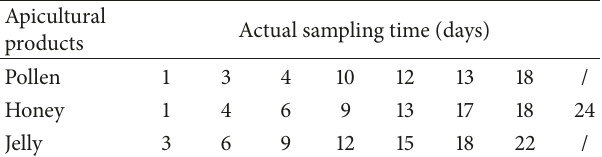
Table 1: Actual sampling time after spraying application in field